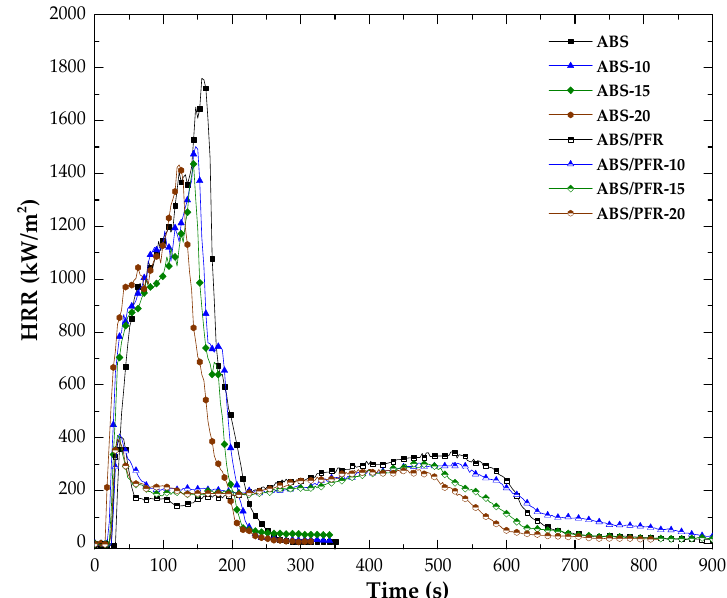
Figure 12. Characteristic HRR versus time curves of unfoamed and foamed ABS and ABS/PFR.